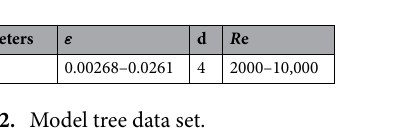
Table 2. Model tree data